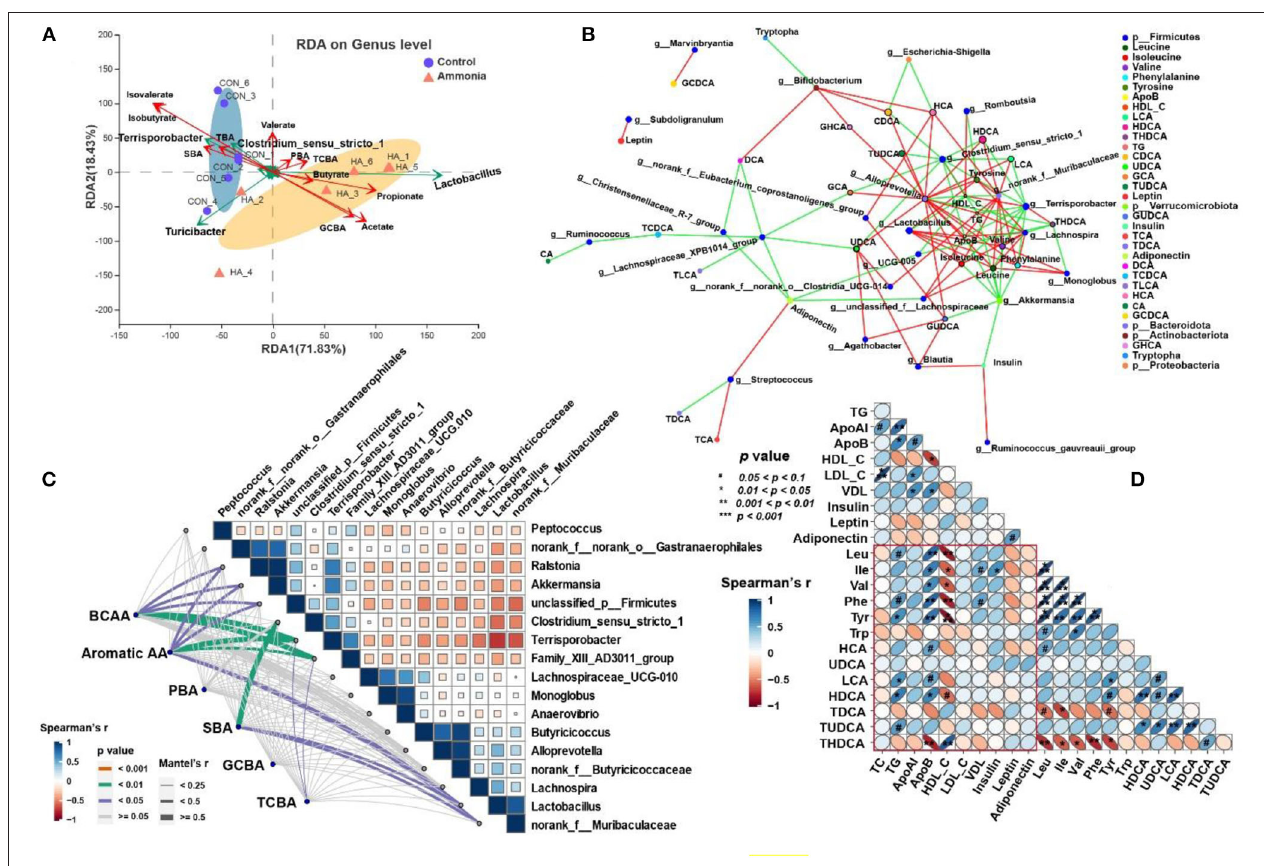
FIGURE 6 | Microbiota–metabolite correlation. (A) Triplot of RDA of the cecal microbial composition at genus level relative to cecal BAs and SCFAs. Microbiota from the control and ammonia groups is indicated by blue circles and orange triangles, respectively. Constrained explanatory variables (cecal TBA, PBA, SBA, GCBA, TCBA, and SCFA) are indicated by red arrows. Responding taxa are indicated by green arrows, and only those with higher fit in the ordination plot are labeled. The first (71.83% interpretation) and second coordinates (18.43% interpretation) are plotted. (B) A network for correlation analysis among the top 50 relative abundance of cecal bacterial genera, serum BA, and AA using relevant networking. Only correlations with Spearman’s coefficient > 0.5 and p < 0.05 are shown. The different color of nodes indicates various targets as demonstrated in legend. The line color represents correlation, and red and green represent positive and negative correlation, respectively. The more lines there are, the more connected the nodes are. (C) Pairwise comparisons of different cecal genera are demonstrated with a color gradient denoting Spearman’s correlation coefficient. BCAA, aromatic AA, PBA, SBA, TCBA, and GCBA are related to each microbial genus by Mantel’s correlation analysis. Edge width corresponds to the Mantel’s r statistic for the corresponding distance correlation, and edge color denotes statistical significance. (D) Half Spearman’s correlation matrix of serum BCAA (Leu, Ile, and Val), Aromatic AA (Phe, Tyr, and Trp), serum BA, and lipid parameters. The red and blue ellipses represent negative and positive correlations, respectively, and the width of ellipses represents strength of correlation (narrow ellipses mean stronger